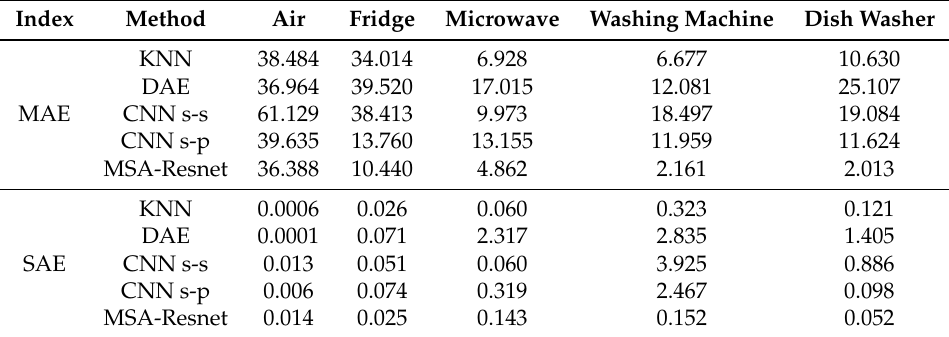
Table 1. Comparison of load disaggregation index of Household 25 of the WikiEnergy dataset.